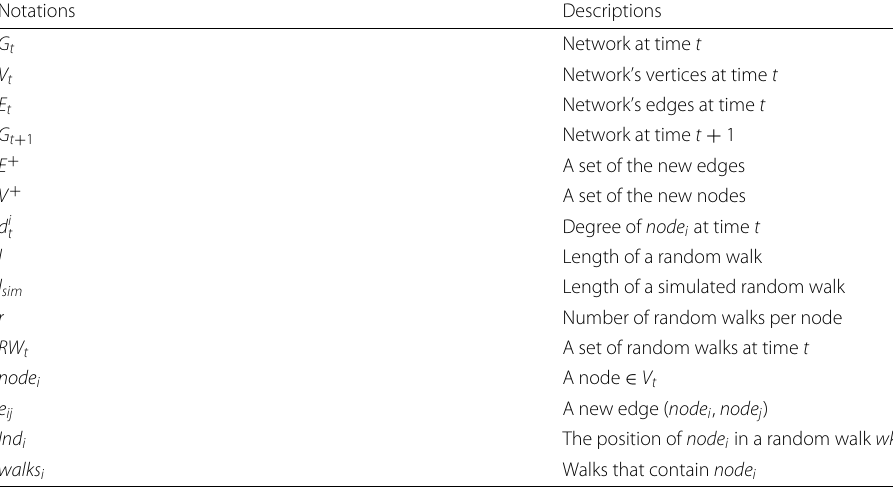
Table 1 Summary of notations used in the dynamic random walk